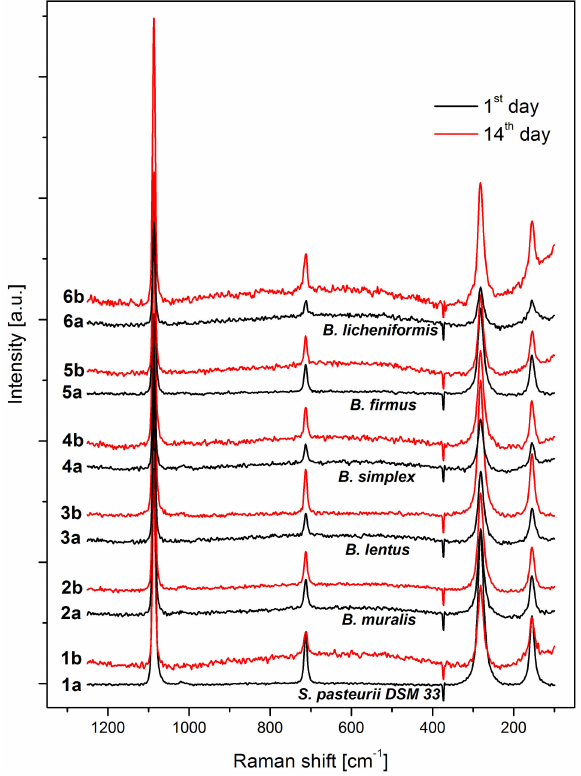
Figure 8. RAMAN spectra CaCO 3 precipitates (a—1st day; b—14th day; 1— S. pasteurii DSM 33; 2— B. muralis ; 3— B. lentus ; 4— B. simplex ; 5— B. firmus ; 6— B. licheniformis